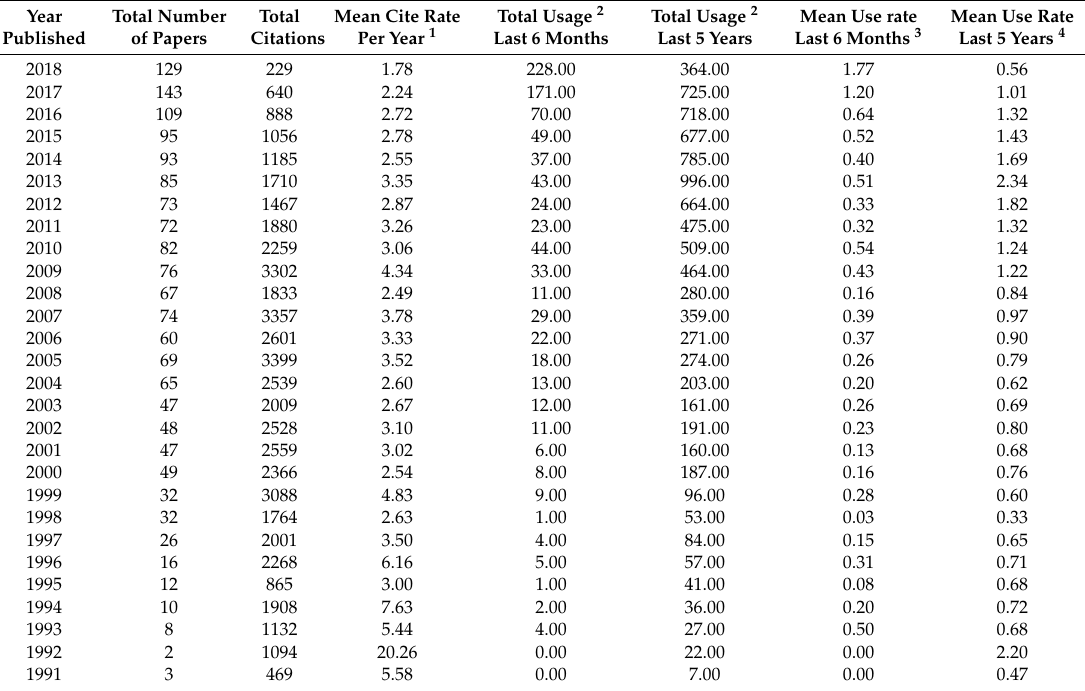
Table 2. General characteristics of publications